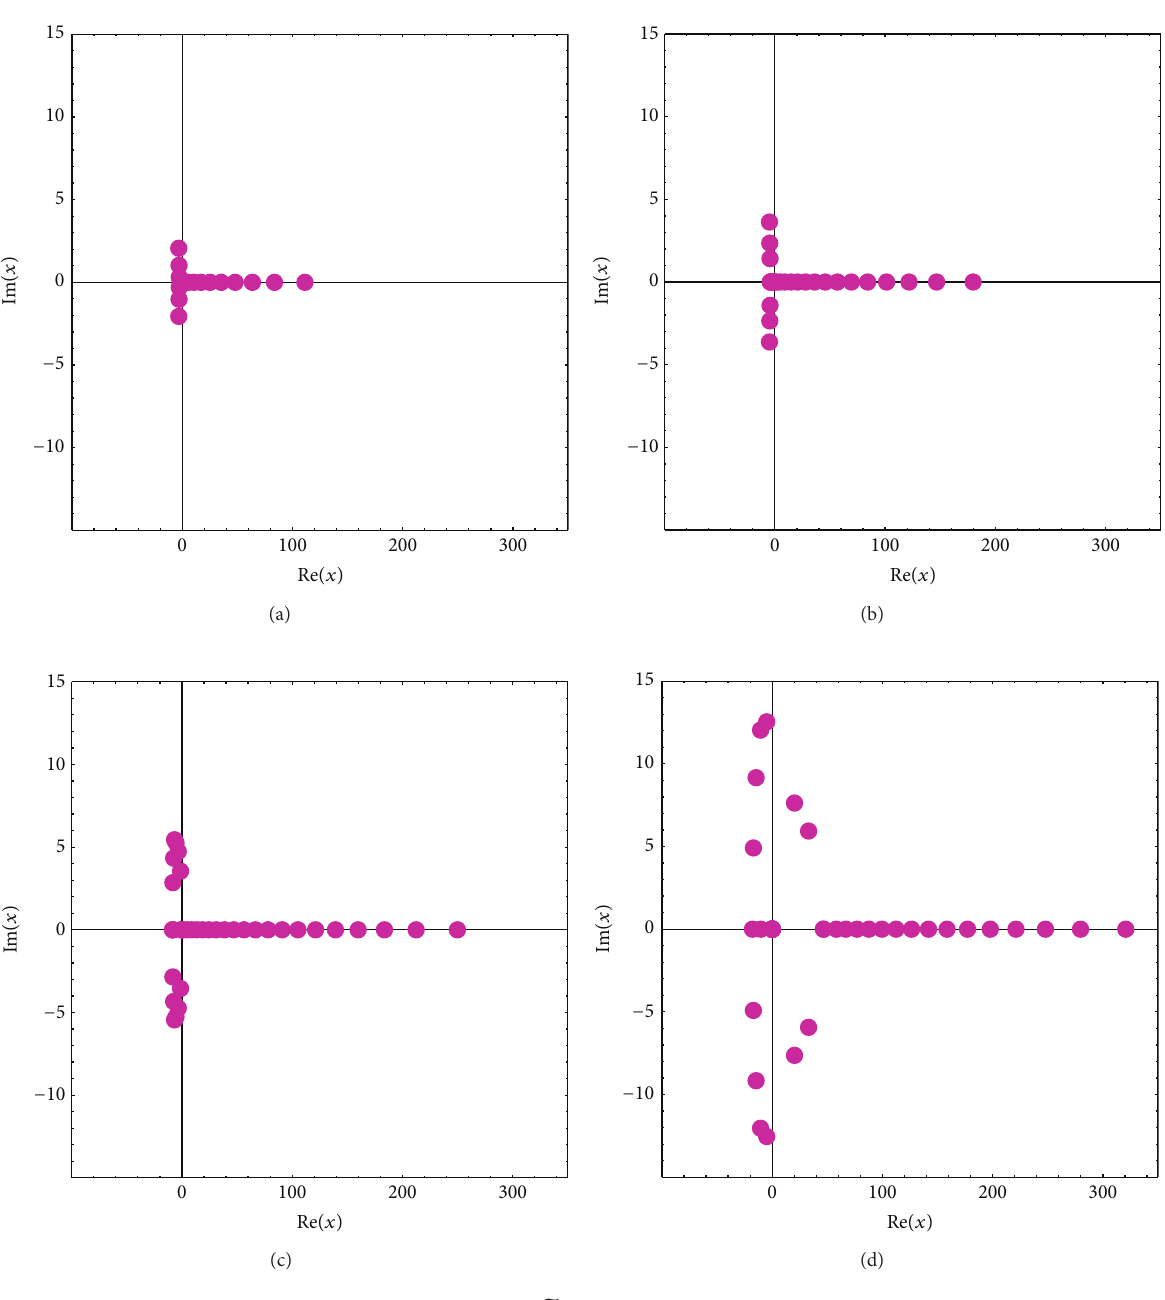
Figure 1: Zeros of